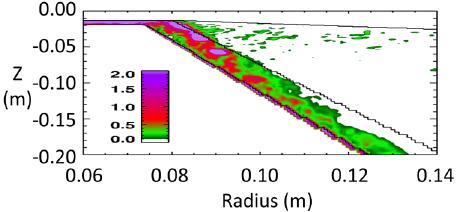
FIG. 24. Electron density in the disk feed in units of Coulombs = m 3 .